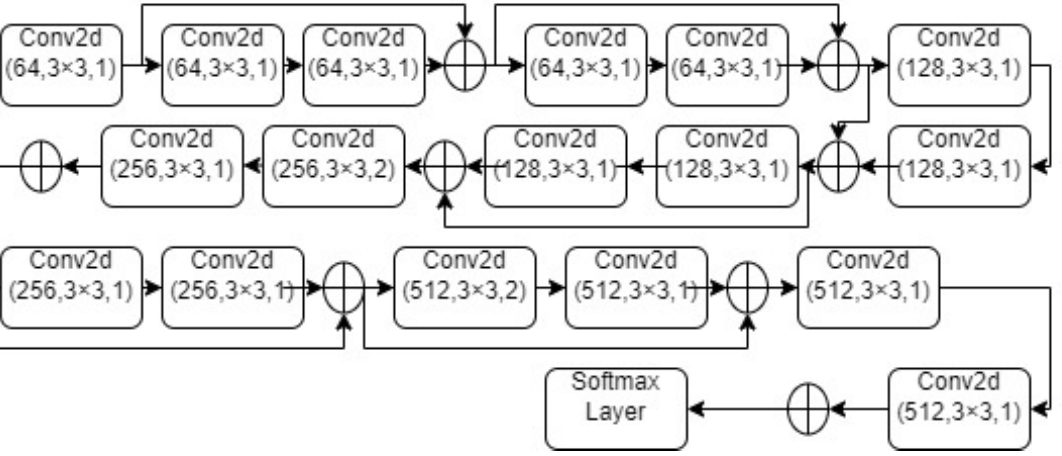
Figure 3. Architecture of ResNet-18. Values in brackets represent the number of filter present in the layer, the size of the filter, and the stride of the filter.